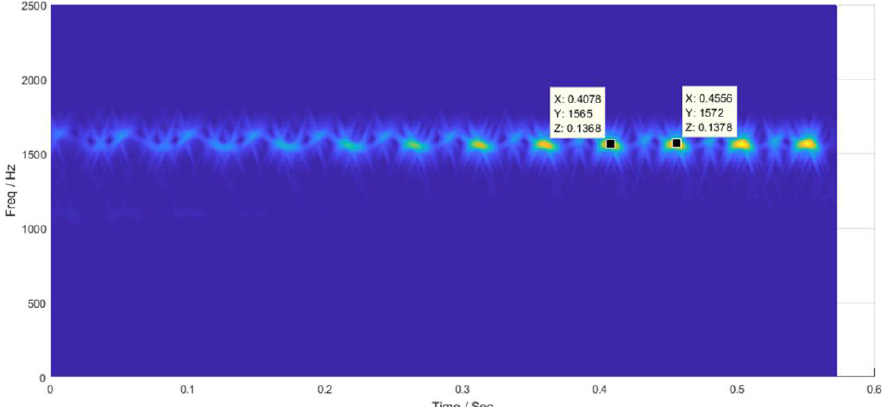
Figure 11. Values of the marks of the chirplet time-frequency representation of the harmonic part for 3 honing cycles of experiment 7.